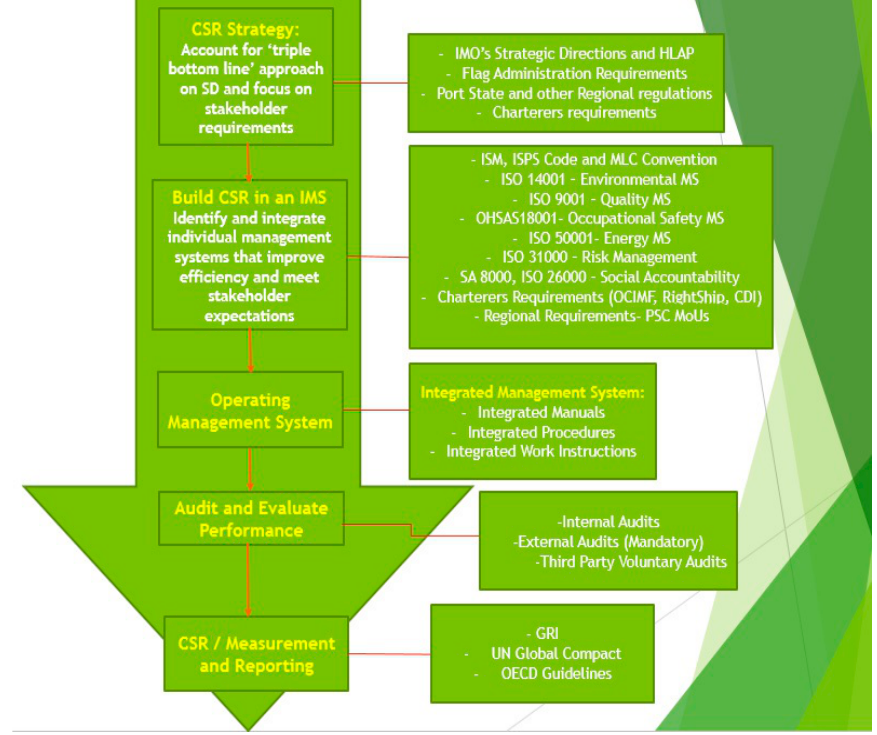
A conceptual corporate social responsibility (CSR) framework for a sustainable maritime